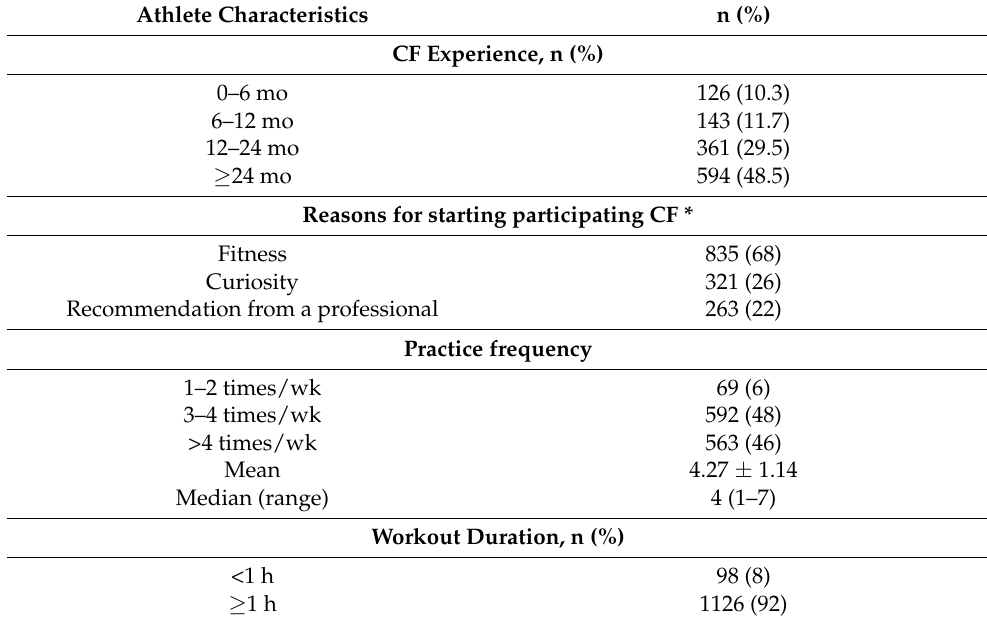
Table 3. CF participant